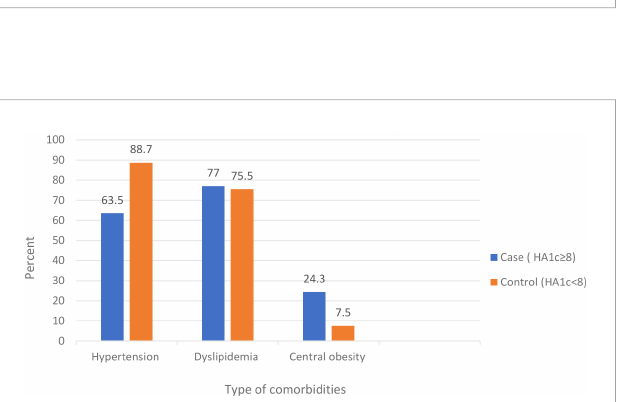
FIGURE 2 Comorbidities among type 2 diabetes mellitus patients at DM clinic of UOGCSH, Northwest Ethiopia, 2020.